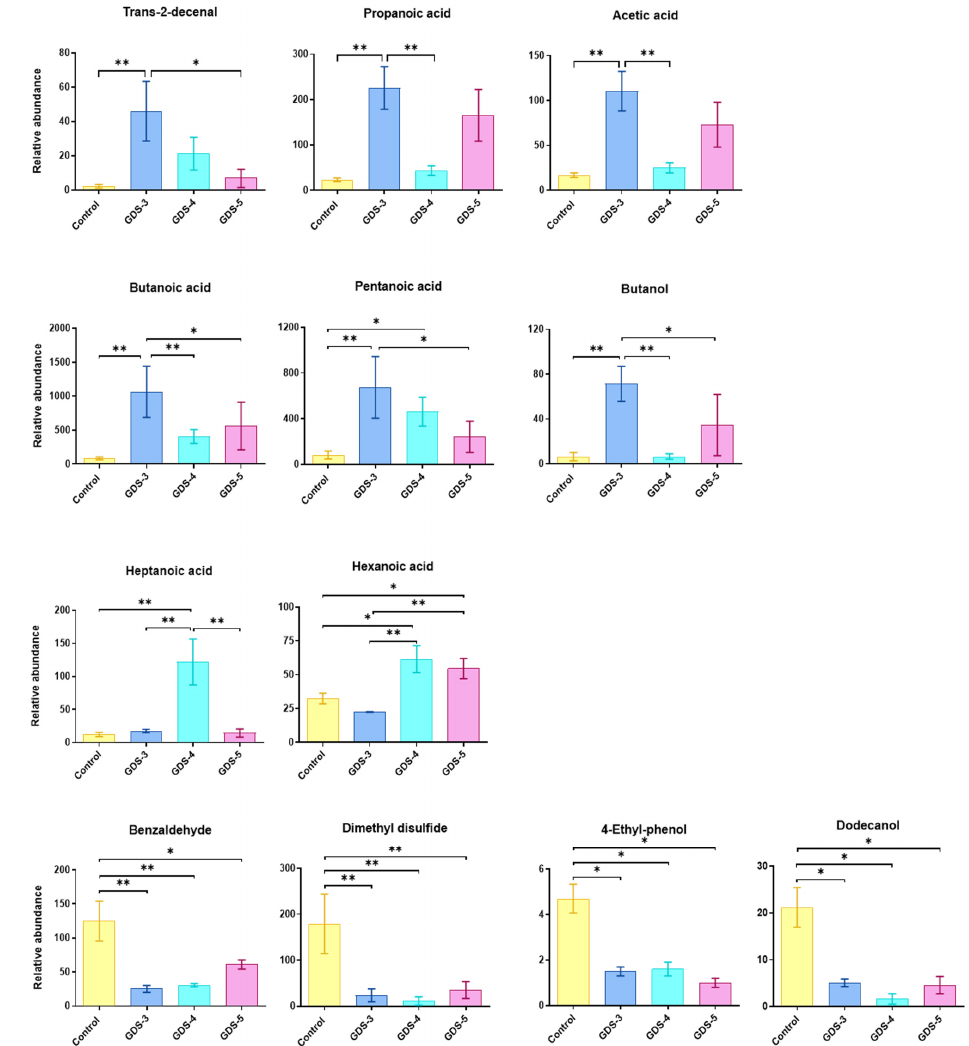
Figure 5. Fecal volatile organic compounds (VOCs) selected by the VIP scores in the control subjects and the Alzheimer’s disease (AD) patients who showed significant differences between the control and/or the AD stages. The VOCs relative abundance in the feces from the control subjects and AD patients were classified in stages GDS-3, GDS-4 and GDS-5. The data are the means ± the SEM, (n = 10, control subjects; n = 12, AD patients; 4 per stage). The ANOVA showed an effect ( p < 0.05) of AD classified in the stages on the relative abundance of the selected VOCs. Tukey’s test: * p < 0.05 and ** p < 0.01.